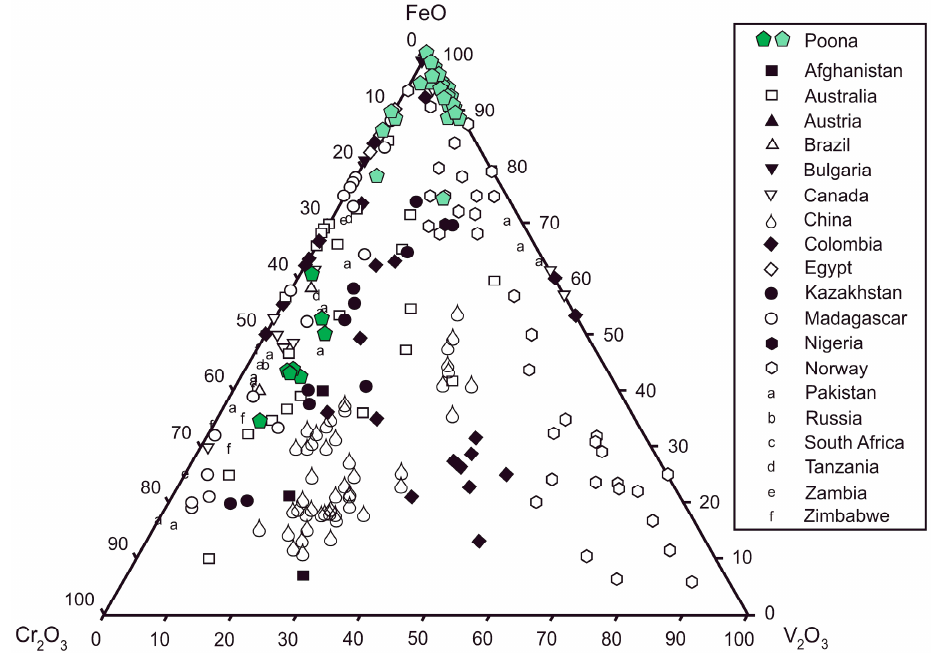
Figure 4. Ternary FeO–Cr 2 O 3 –V 2 O 3 (wt %) plots of Poona emerald compositions (dark and light green hexagons, corresponding to emerald and green beryl respectively) superimposed on the worldwide emerald compositions from literature data compiled in [6,7,25,27]. Data are normalized from wt % microprobe analyses (Table 1), with Fe data reported as FeO. Other Australian emerald data are from Menzies and Emmaville-Torrington.